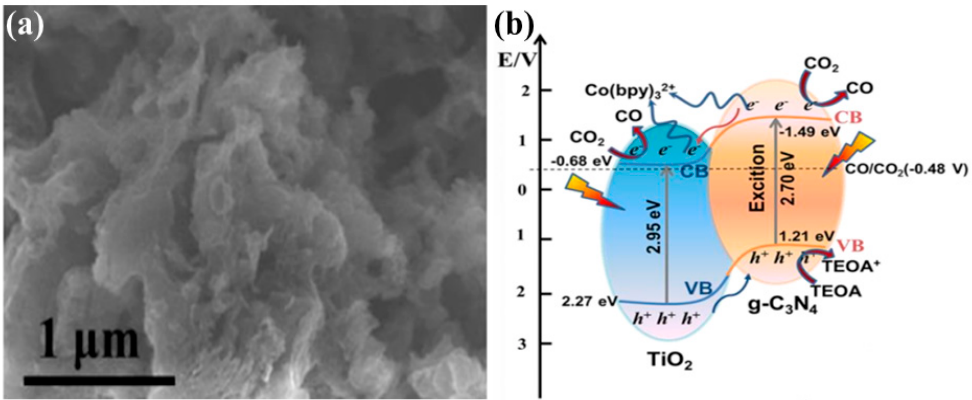
Figure 8. ( a ) SEM image of a representative TiO 2 − x / g-C 3 N 4 sample displaying sheet-type g-C 3 N 4 embedded with TiO 2 − x nanoparticles, and ( b ) schematic of the electronic structure of TiO 2 − x / g-C 3 N 4 with the proposed mechanism of photocatalytic CO 2 conversion (taken with permission from [64]).